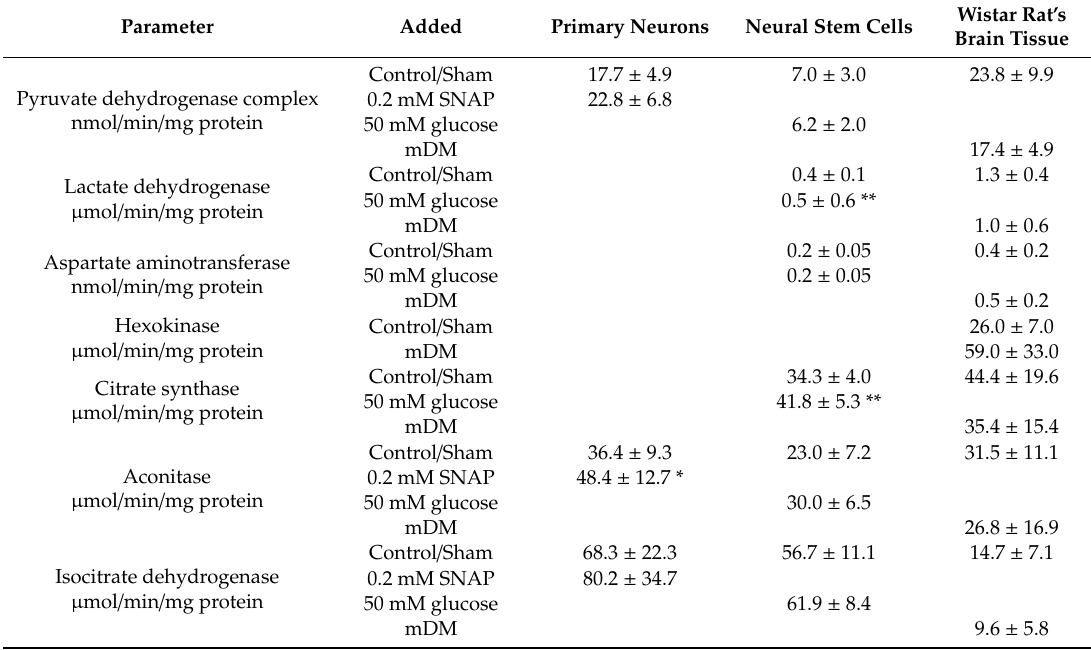
Table 1. Enzymatic activities measured in Wistar rat brains.